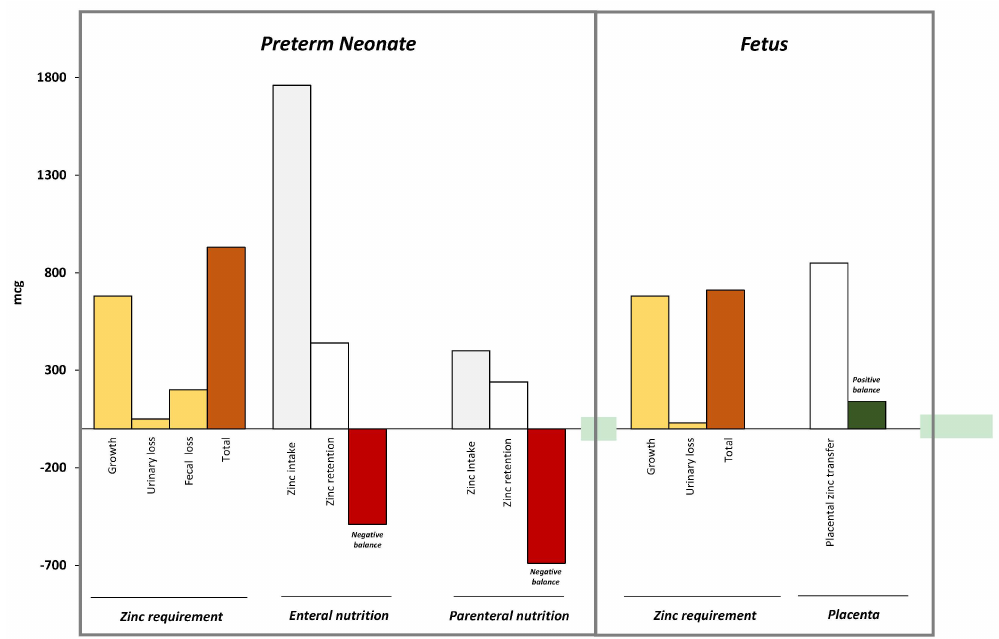
Figure 4. Zinc balance in fetal and neonatal life